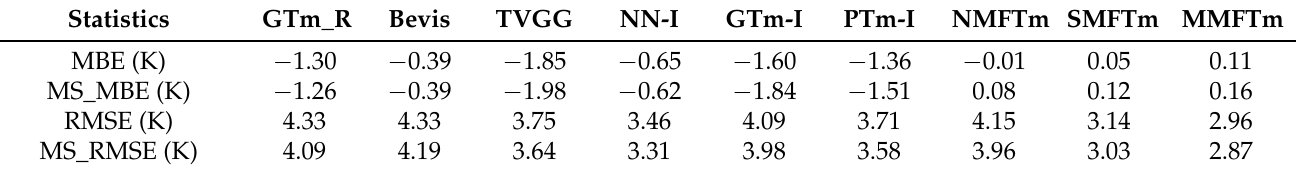
Table 3. Statistics of T m estimates for different models tested by radiosonde data from 2016 to